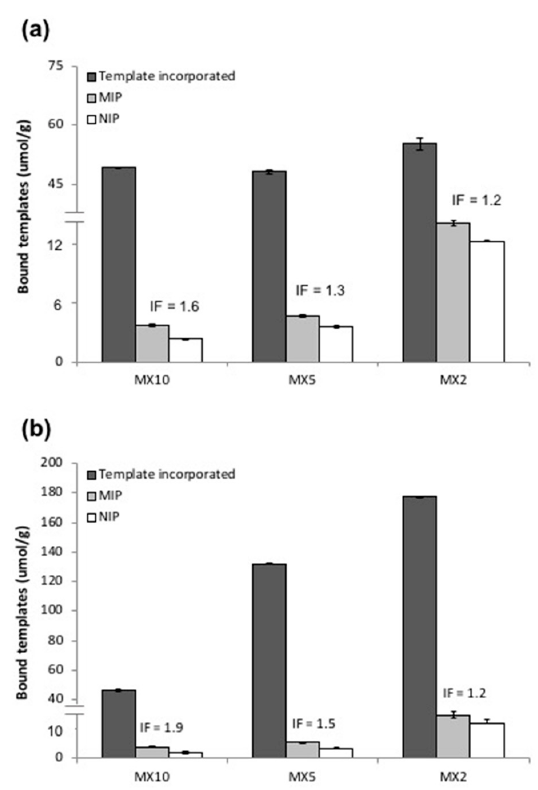
Figure 4. Comparison of the amount of ( a ) CAF and ( b ) THP incorporated and rebound by the MIPs and NIPs prepared from various fM:X ratios. Polymers were incubated for 18 h in 100 µM template rebinding solution and the post rebinding solutions were analysed by HPLC.